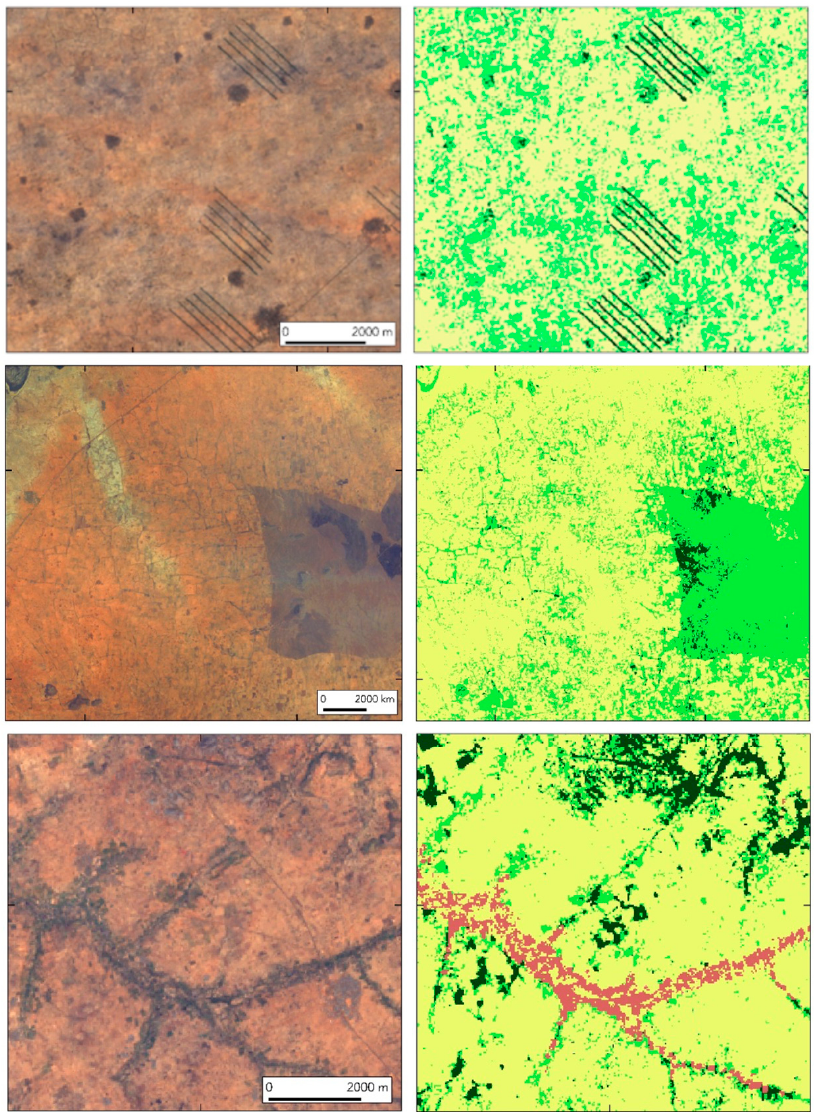
Figure 5. Examples of Google Earth high resolution imagery (left side) and the corresponding 30 m resolution Landsat 8-based LCLU map for northern Nigeria (right side). Dark green: stable natural vegetation; Light green: non-stable natural vegetation; Light yellow: rain-fed agriculture; Red: Irrigation agriculture. Table 2. Accuracy matrix